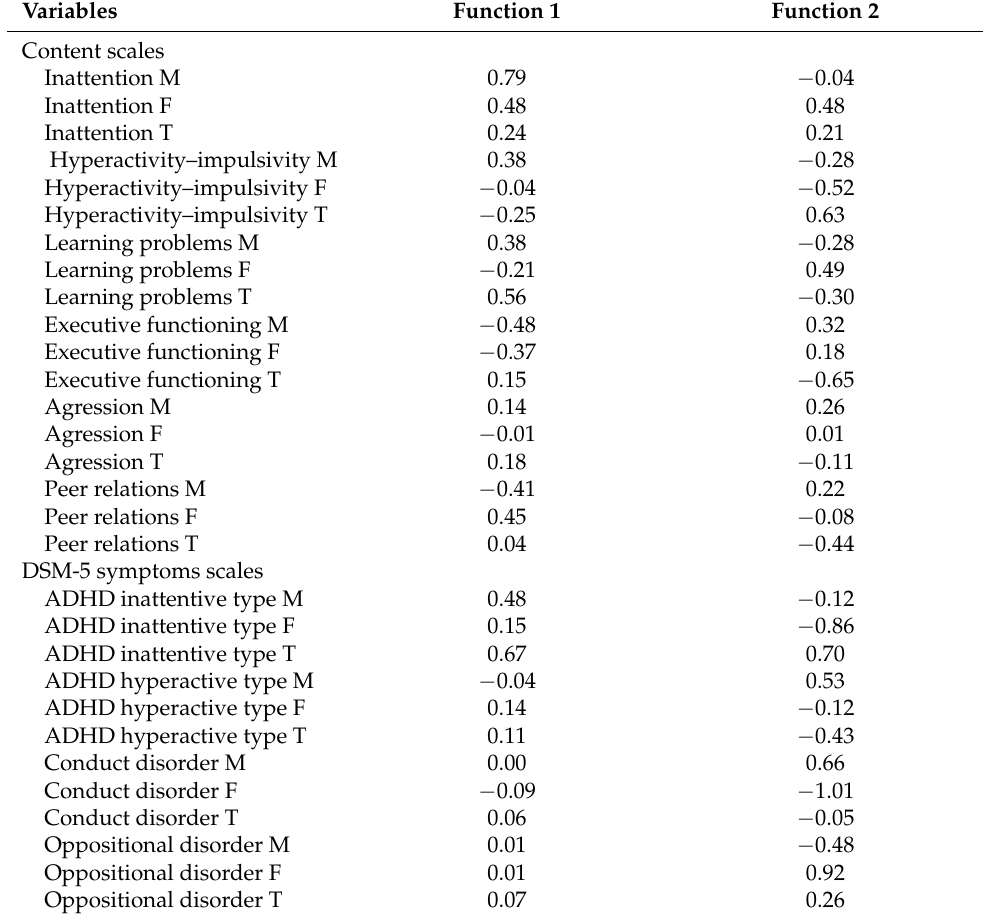
Table 3. Standardized canonical discriminant function coefficients for the Conners 3 content and the symptoms scales.